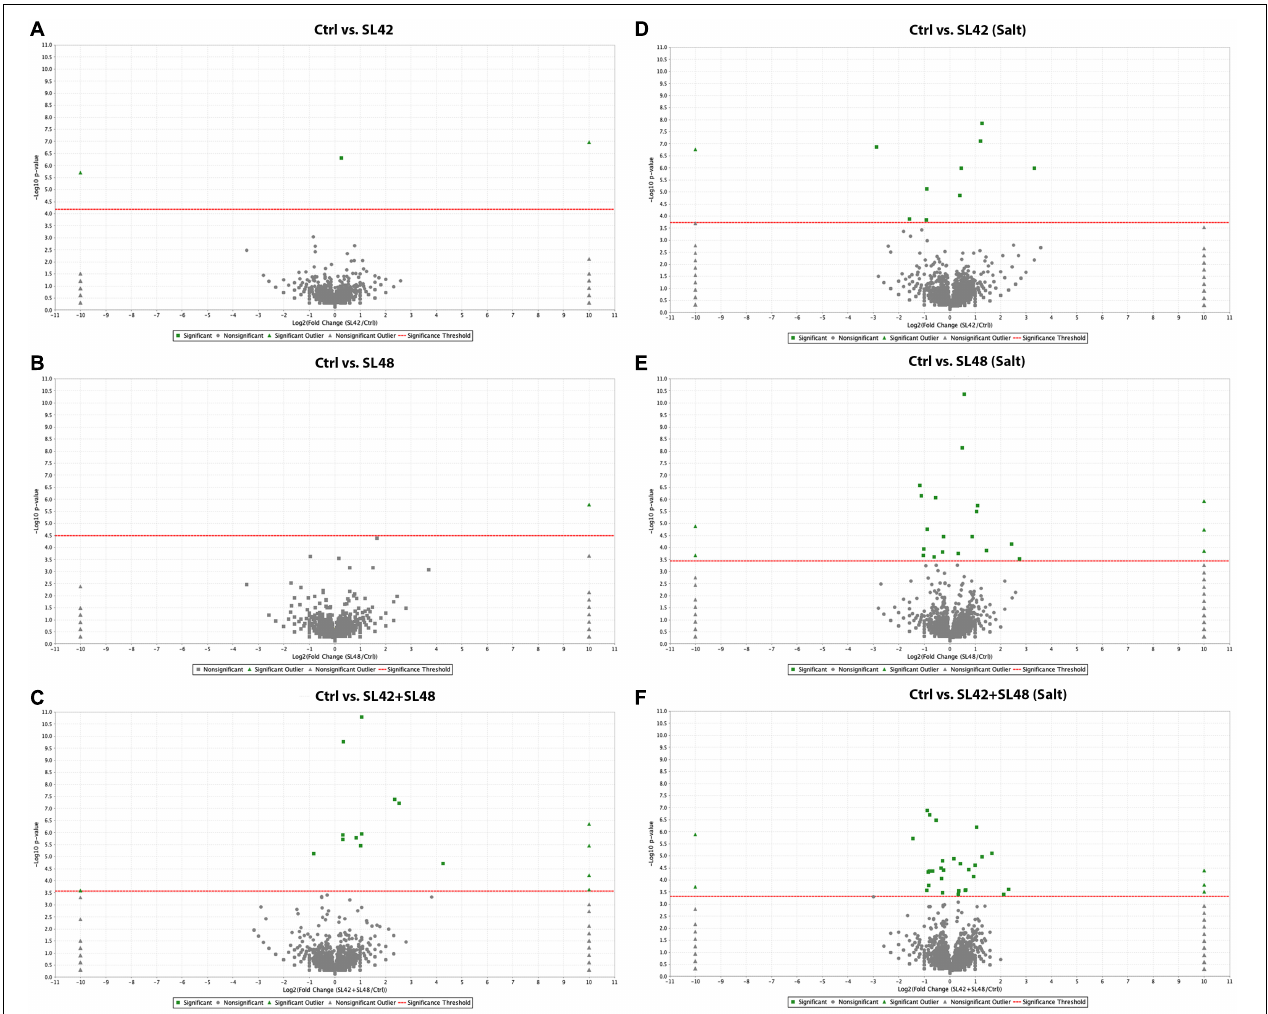
FIGURE 2 | Volcano plots of quantitative spectra comparison between control and bacterial inoculated treatments under optimal and salt-stressed conditions. (A) Ctrl vs. SL42 (B) Ctrl vs. SL48 (C) Ctrl vs. SL42 + SL48 (D) Ctrl vs. SL42 (salt) (E) Ctrl vs. SL48 (salt) (F) Ctrl vs. SL42 + SL48 (salt). Fold change by category, reference control treatment is plotted on X-axis and Fisher’s exact test (Benjamini-Hochberg correction) is plotted on